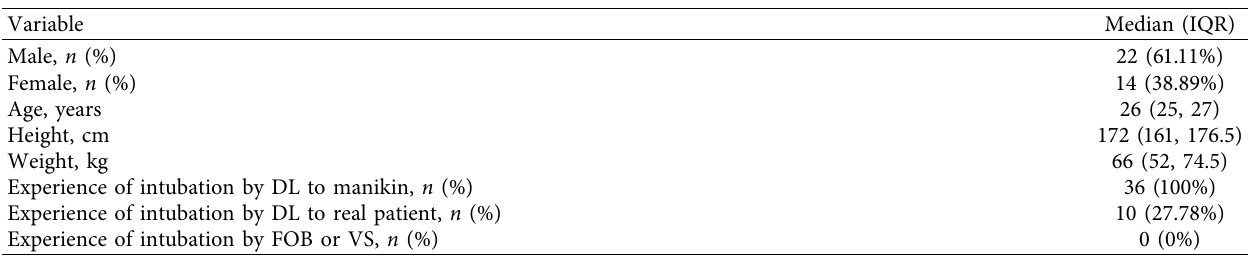
Table 2: Comparison of fiberoptic bronchoscope with modified airway and fiberoptic bronchoscope alone. FOB with MA FOB alone p value Effect size ( r ) Time to see the glottis, seconds 5 (4, 7.5) 7 (5, 10) 0.032 0.357 Time to complete intubation, seconds Success, n (%) — FOB, fiberoptic bronchoscope; MA, modified